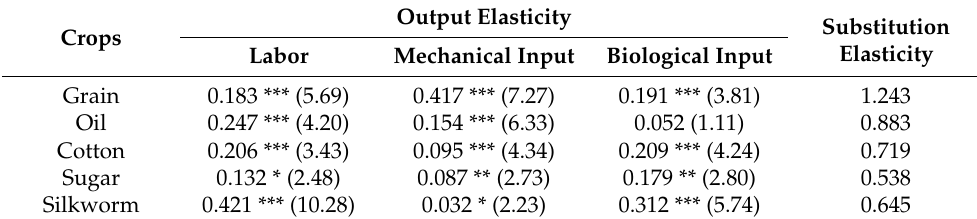
Table 1. The estimated results of production factor output